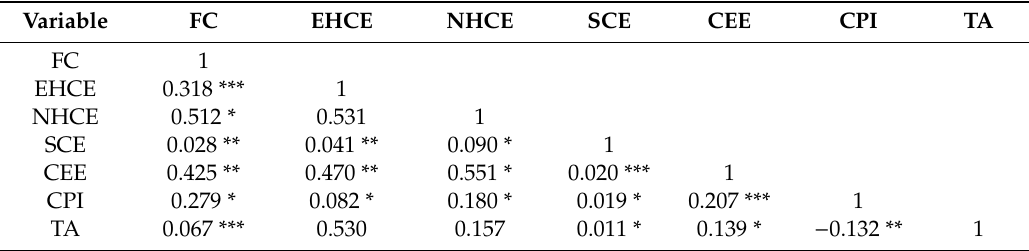
Table 3. Correlation coe ffi cients among variables in non-high-tech agriculture companies (NHTAC).